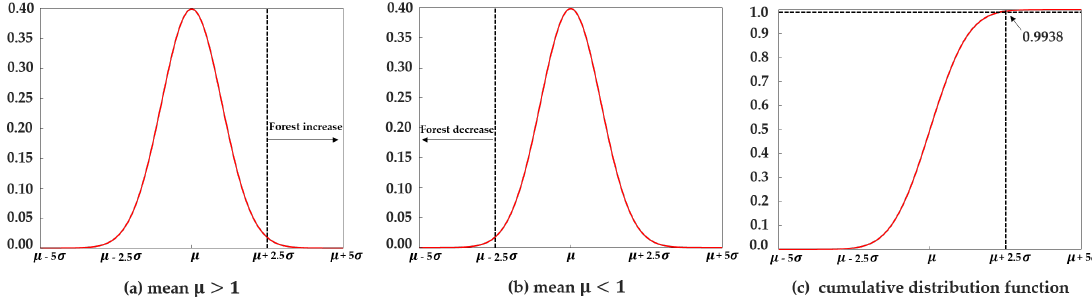
Figure 5. This figure shows the definition of the threshold in the distribution of a ratio image for detecting forest